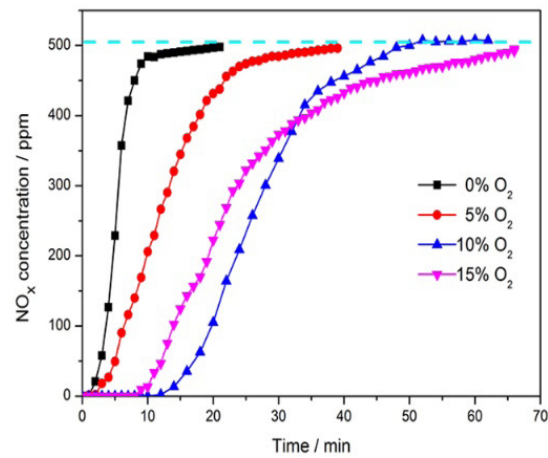
Figure 5: Adsorption patterns of catalyst under the process of 0% O and 10% O at 350 . 2 ℃